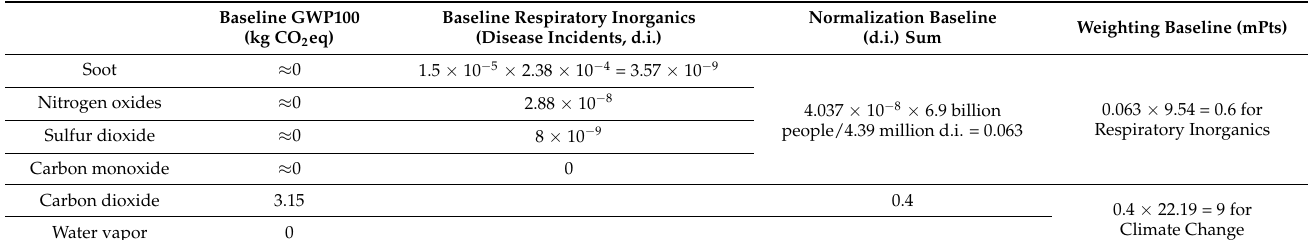
Figure 1. ILCD 2011 Mid-point+ results per kg fuel for air transport. Table 6. Baseline approach EF Method.